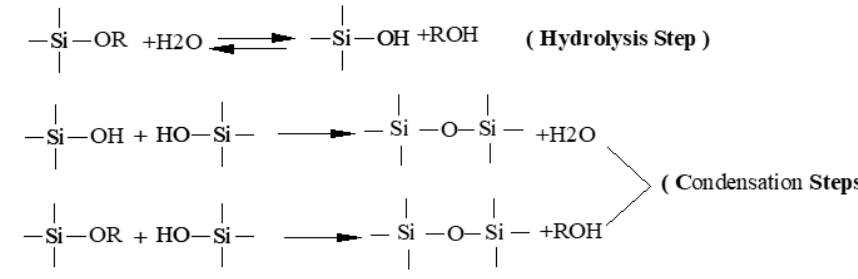
Figure 3. SEM morphology of silane sealed PEO coating: Surface ( a ) and cross-section ( c ) morphol- ogy of PEO-S1; Surface ( b ) and cross-section ( d ) of PEO-S2.